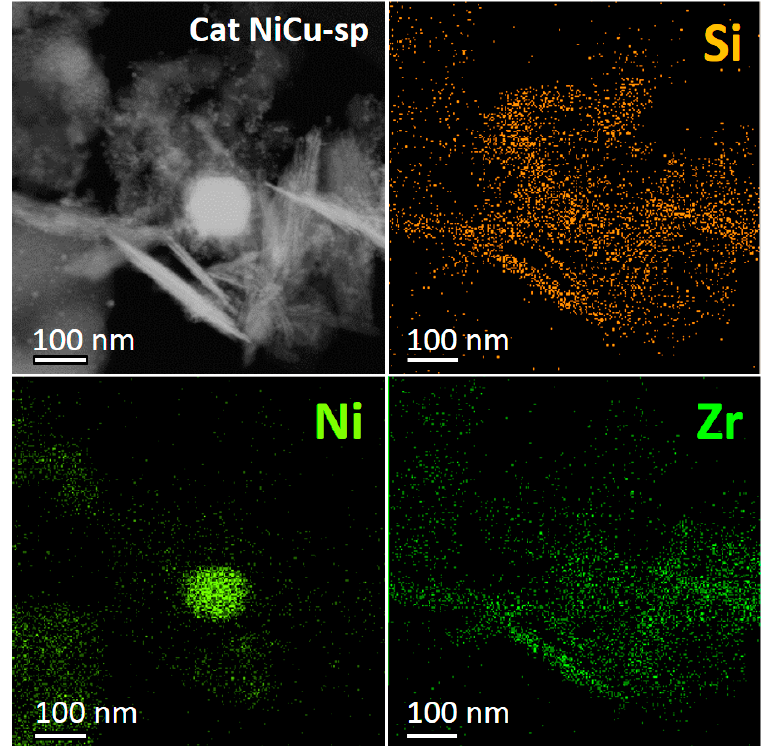
Figure 10. EDX mapping of spent NiCu/SiO 2 -ZrO 2 catalyst.